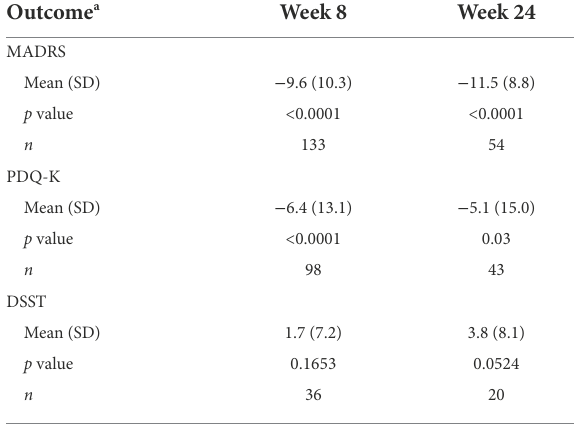
TABLE 2 Change in MADRS, PDQ-K, and DSST scores from baseline after 8 and 24 weeks of vortioxetine treatment (effectiveness analysis